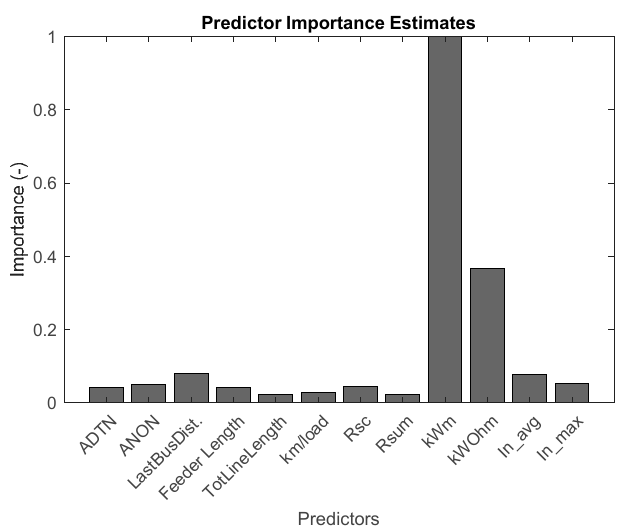
Figure 5. Estimation of the importance of each predictor (variable) for the fully-grown tree.